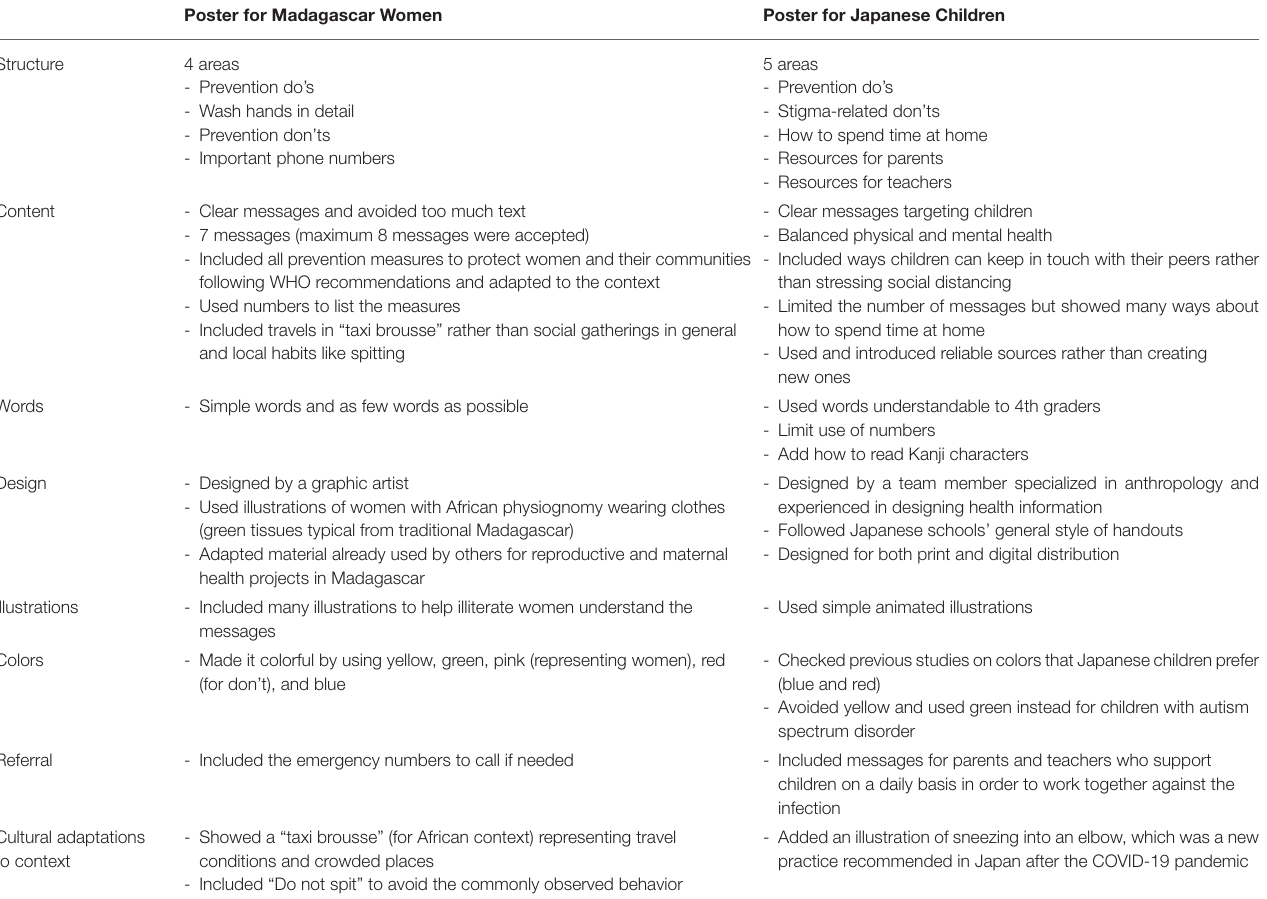
TABLE 3 | Health information materials from the two cases: framing general protections measures in a country-specific context. Poster for Madagascar